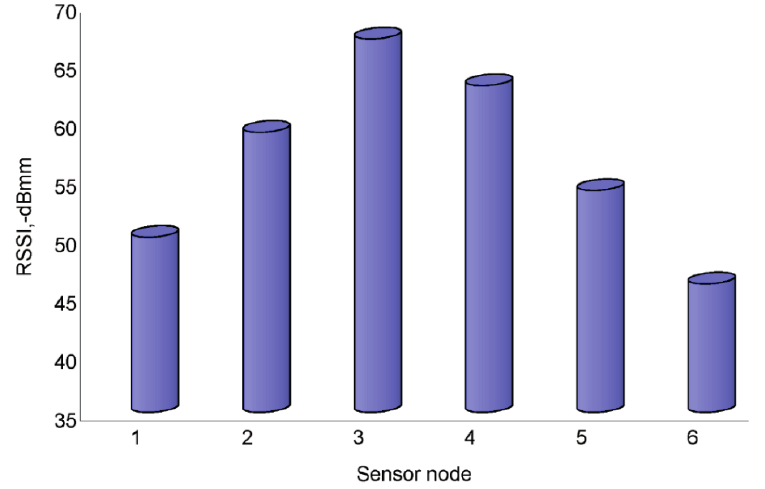
Figure 12. The RSSI of each link between the network coordinator and each sensor node.